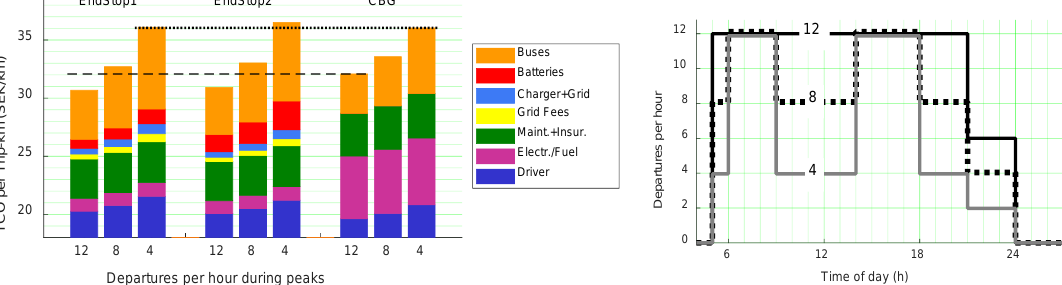
Figure 14. The cost per km for end-stop-charged and biogas (CBG) buses with varying bus traffic density off-peak. (Note that the y -axis starts at 18 SEK/km, so the driver cost is more than half the TCO).